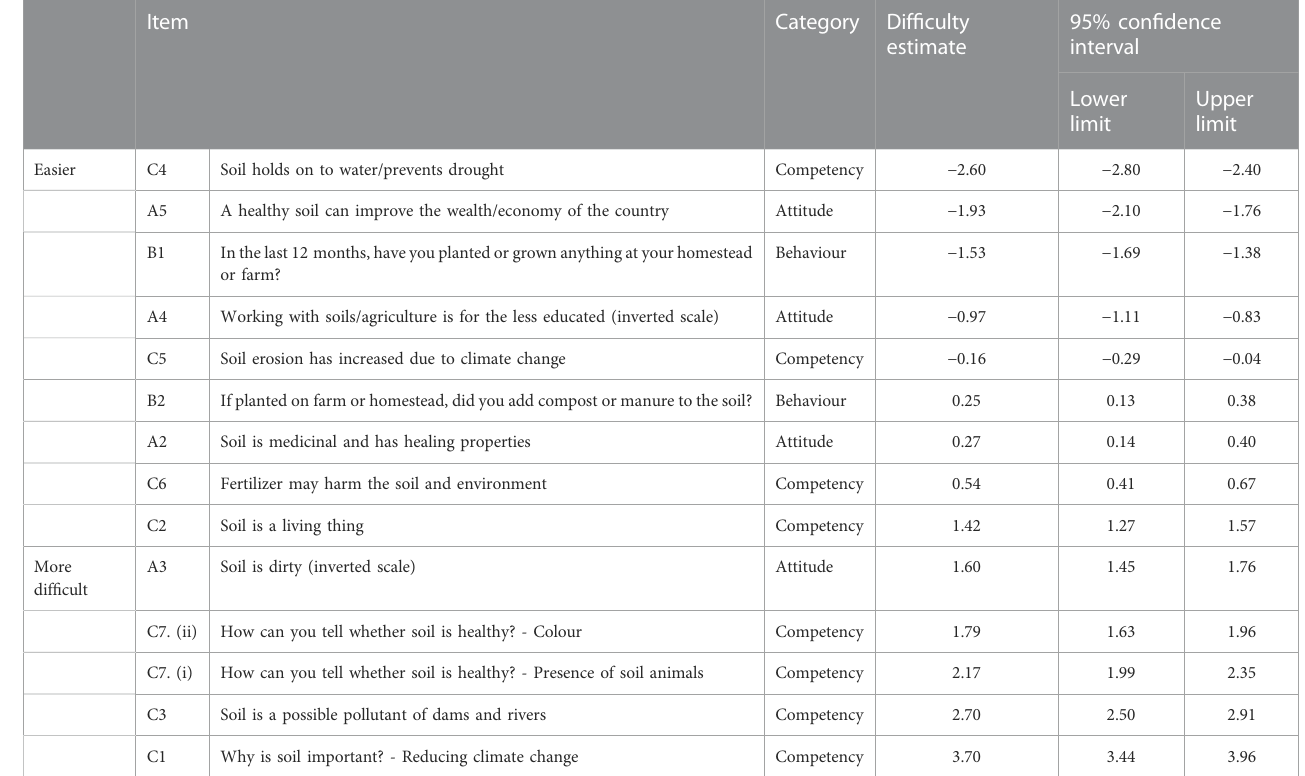
TABLE1Abridgedversionsofthequestionsaskedinthesurvey,inorderoftheir ‘ dif fi cultyratings ’ .ThemethodologicalapproachknownasItemResponseTheory(IRT) was used to assess question dif fi culty (Table taken from, and more details in, Johnson et al.,